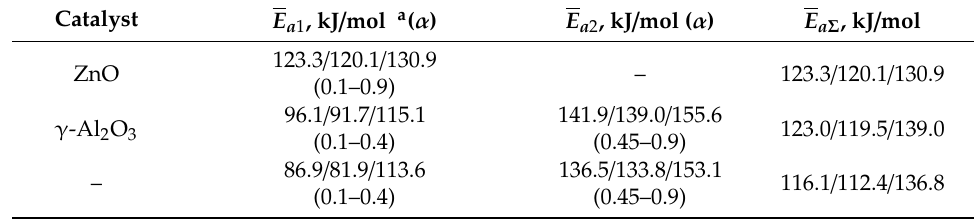
Table 4. Activation energy values of GAO:LAO mixture depolymerization (for α